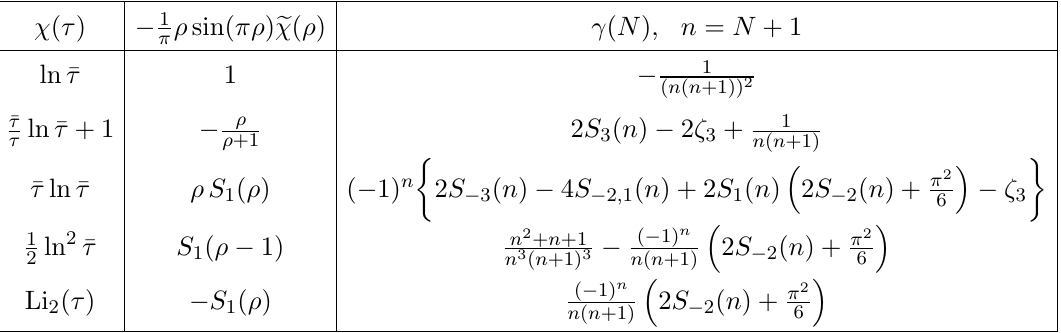
Table 3 . Mellin transformation (5.23) for several typical kernels and the corresponding contribu- tions to the anomalous dimensions. Here S 1 ( (cid:26) ) = ( (cid:26) + 1) (cid:0)